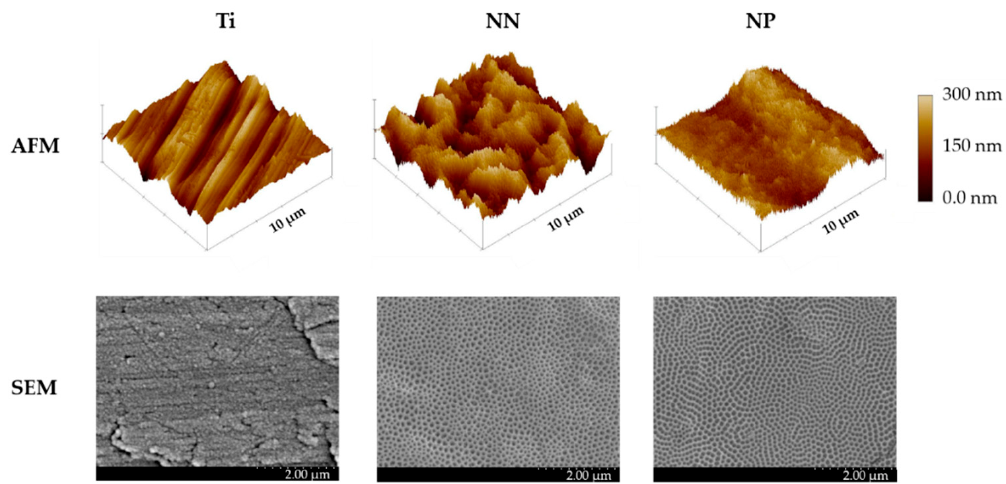
Figure 1. Physical characterization of nanostructured surfaces. Representative AFM (atomic force microscopy) and SEM (scanning electron microscopy) images of the different nanostructured titanium surfaces. Scale bars for AFM images represent 10 µm and those for SEM images represent 2.0 µm. NP, nanopore; NN, nanonet.